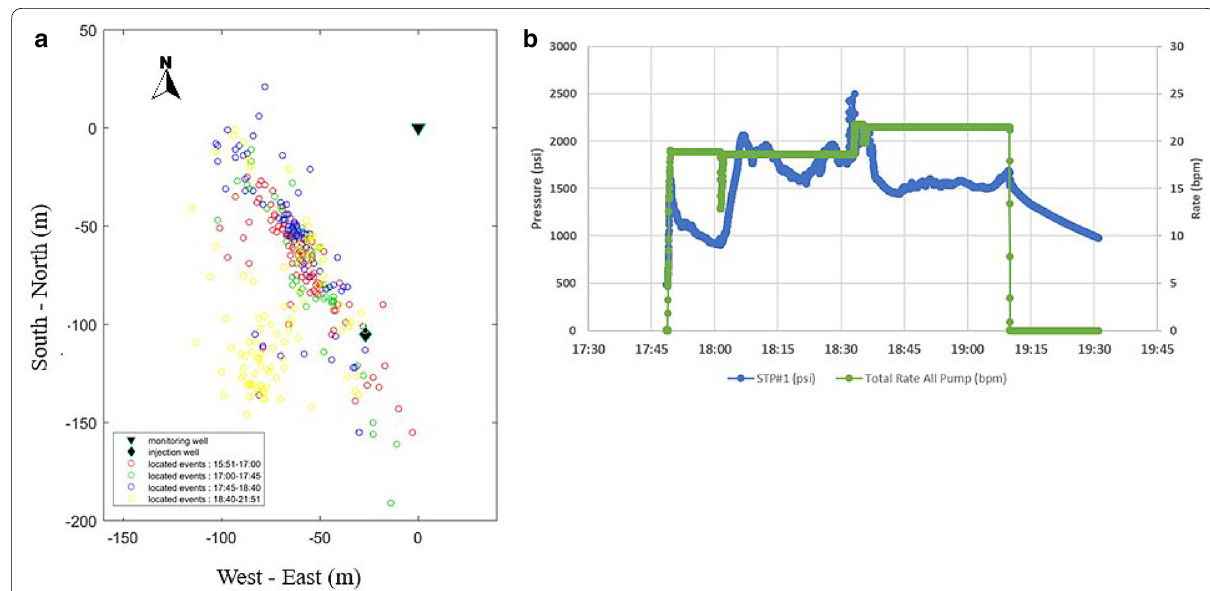
Fig. 1 The microseismic events colored by time of occurrence suggesting microseismic events were initiated from the treatment location, propagated along N330° orientation, and N240° at later time ( a ), associated with fluid injection program ( b